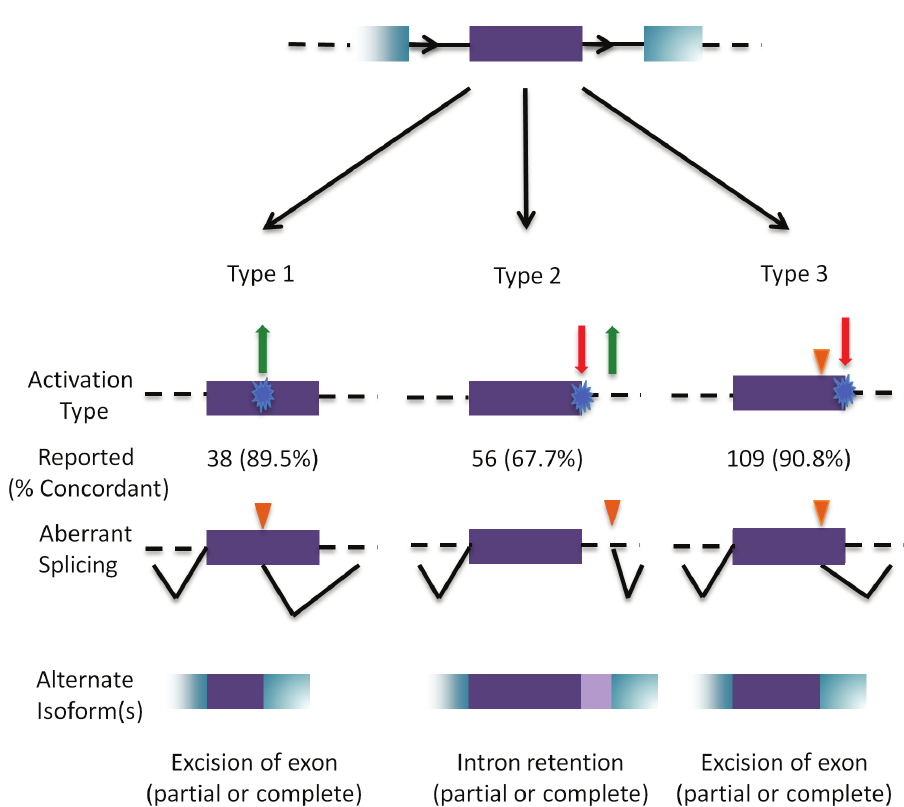
Figure 4. Outcomes of cryptic splicing mutations. A prototypical internal exon (in purple) with flanking exons (in blue); introns are represented by black solid, and dashed lines (top). The three types of cryptic splice site activation are then illustrated. Type 1 cryptic splice site activation (left) is caused by the activation (green arrow) of a cryptic site by strengthening a pre-existing site, or by creating a novel splice site (blue). Type 2 (middle) results from the simultaneous weakening or abolition (red arrow) of the natural splice site while strengthening or creating (green arrow) a cryptic site. Type 3 (right) involves the activation of a pre-existing cryptic site due to the weakening or abolition of the natural splice site (indicated by orange triangle). The number of cases that have been reported in the literature that has been analyzed by IT for each type is indicated, with the percent accuracy in parentheses. The bottom row represents the resulting mRNA structure due to the activated cryptic splice